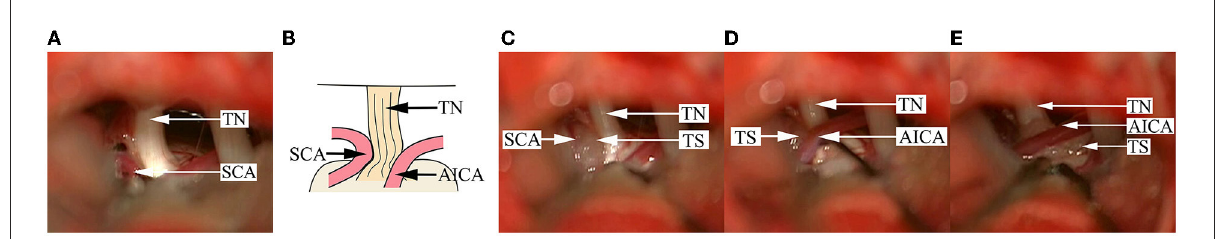
FIGURE4 Findings in a DR patient with two offending vessels compressing the TN. (A) A SCA is seen compressing the superior aspect of the TN REZ, and the nerve root becomes dark and deformed. (B) A schematical picture of (A) . (C) After pushing away the SCA, a Teflon sponge is inserted between the SCA and the TN. (D) Another AICA is seen compressing the dorsal side of the TN REZ, and the surface of the nerve is depressed and changes in color. (E) After pushing away the AICA, a Teflon sponge is inserted between the AICA and the TN to achieve decompression. AICA, anterior inferior cerebellar artery; SCA, superior cerebellar artery; TN, trigeminal nerve; TS, Teflon sponge.